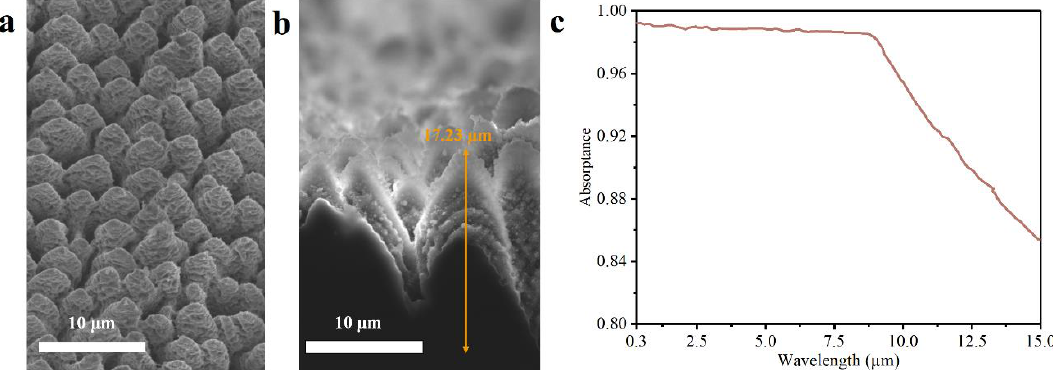
Figure 9. ( a ) The morphology and ( b ) the cross-sectional image of the prepared nanoripple-cone. ( c ) The average corresponding absorption spectrum for three samples treated by the same femtosecond laser parameters, showing approaching results.